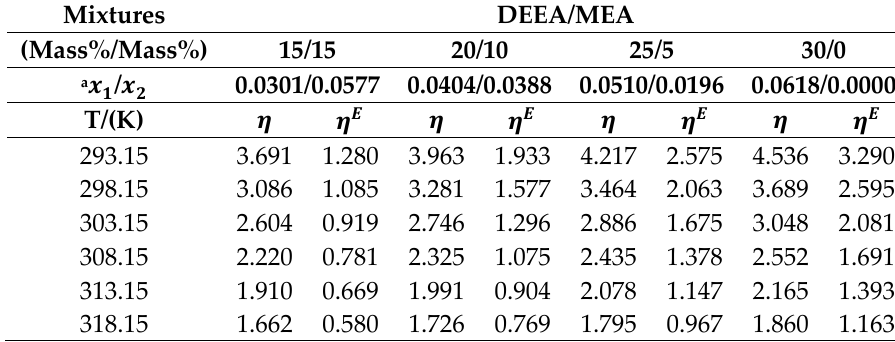
Table 13. Viscosities 𝜂 (mPa · s) and viscosity deviation 𝜂 𝐸 (mPa · s) of DEEA (1) + MEA (2) + H 2 O (3)